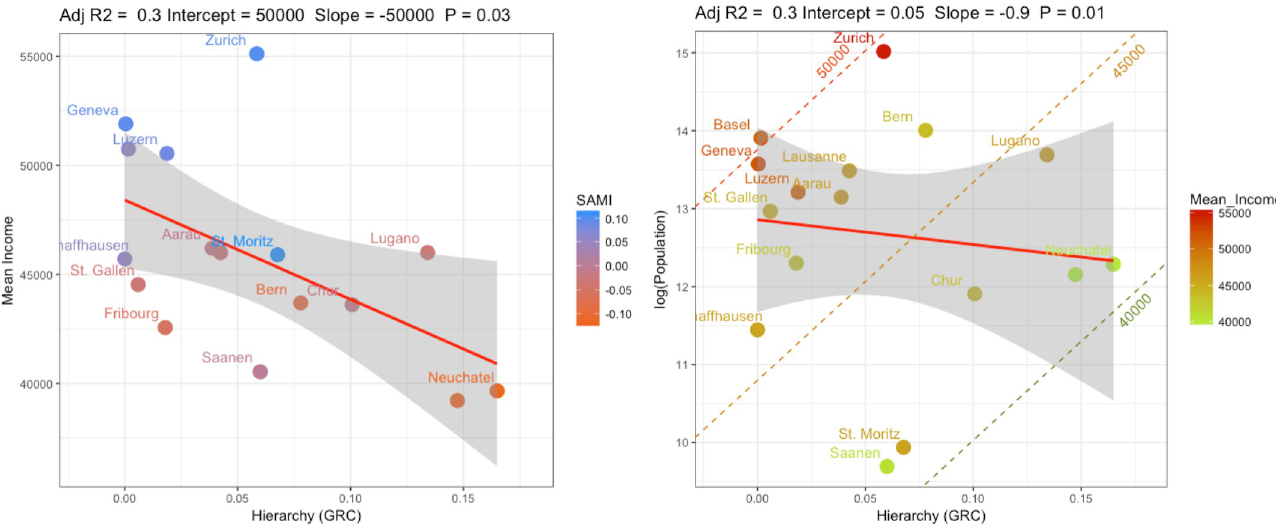
Fig 4. (a) Scatter plot showing the relationship between mean personal income and metropolitan hierarchy (GRC). SAMIs are shown with a colour gradient. (b) Scatter plot showing the interdependence of two explanatory variables. The isoclines represent different mean income levels (i.e. 40’000, 45’000 and 50’000 CHF). The colour gradient shows the mean income of metropolitan areas.